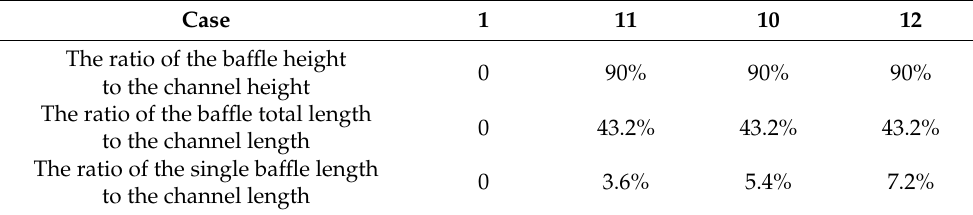
Table 8. Cases under different dimensionless lengths of the single